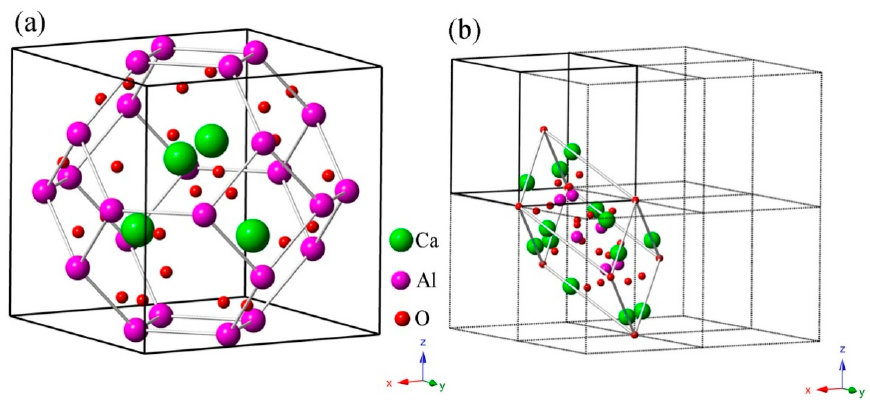
Figure 1. Crystal structure of CAO: ( a ) the unit cell (lattice parameters a = b = c = 8.8214 Å) with a sodalite cage ( β -cage) structure and ( b ) the primitive cell (primitive vectors a 1 = a 2 = a 3 = 7.64 Å) in a 2 × 2 × 2 super cell .